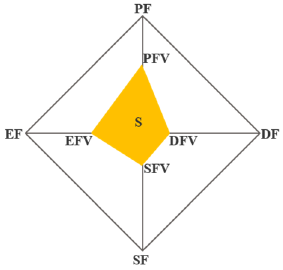
Figure 4. Multi-dimensional evaluation model.